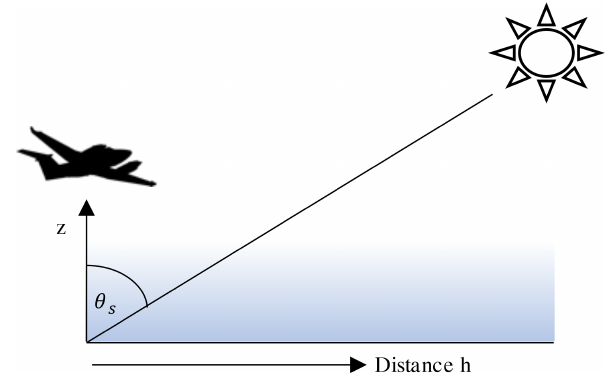
Figure 2. The spatial sensitivity of solar-reflected measurements depends on water vapor absorption along the optical path from the sun to the ground to the sensor. Aircraft image credit: